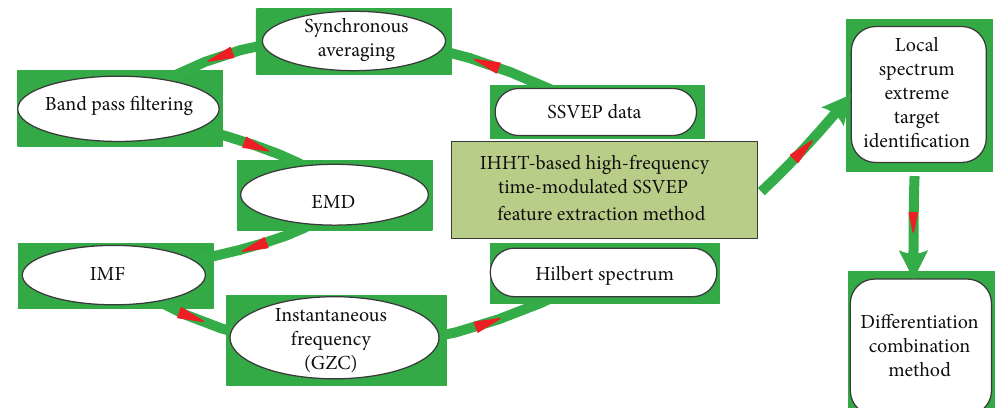
Figure 9: IHHT-based high-frequency time-modulated SSVEP method.